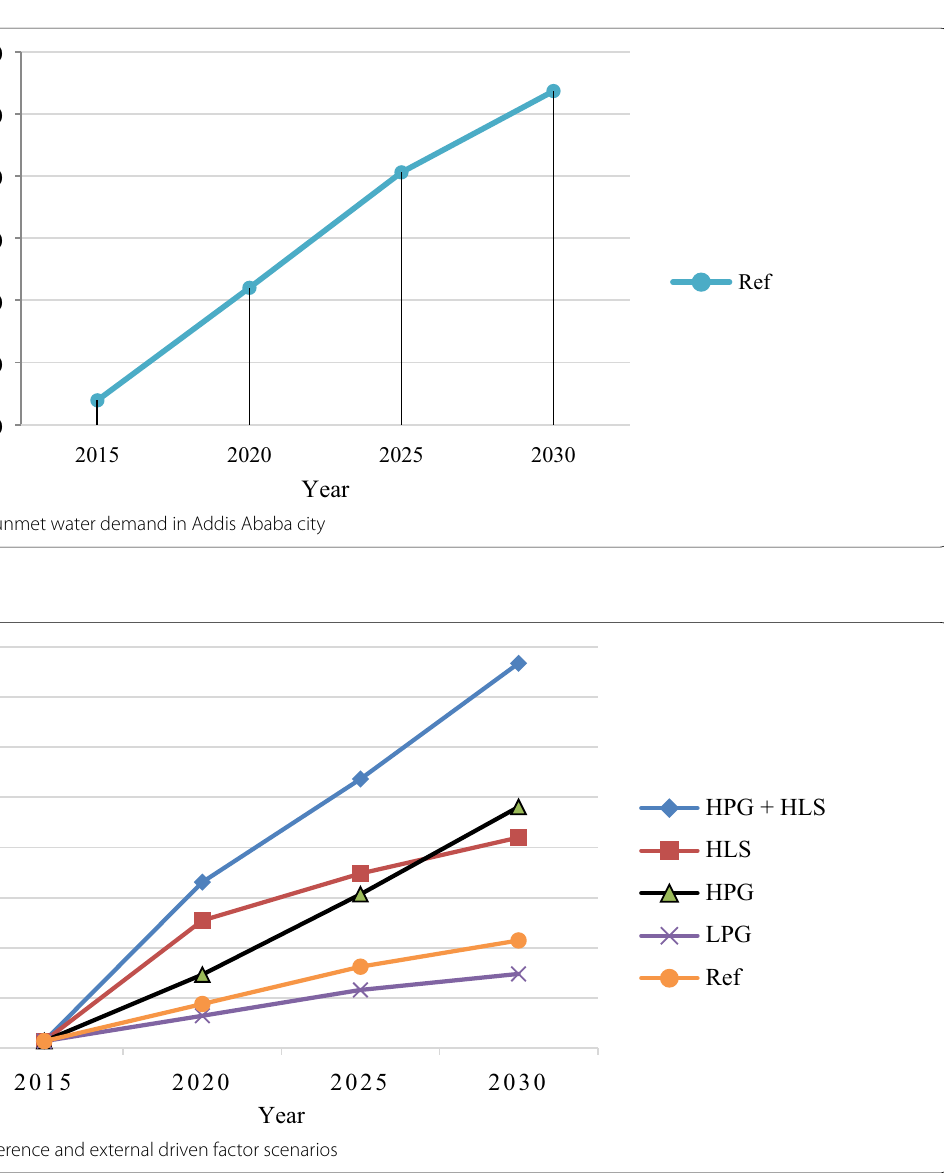
Fig. 4 Unmet demand for reference and external driven factor